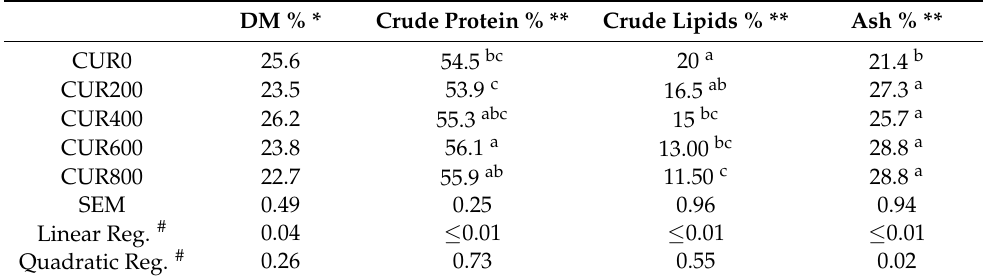
Table 3. The effects of dietary curcumin (CUR) on the proximate whole-fish body composition of O. niloticus